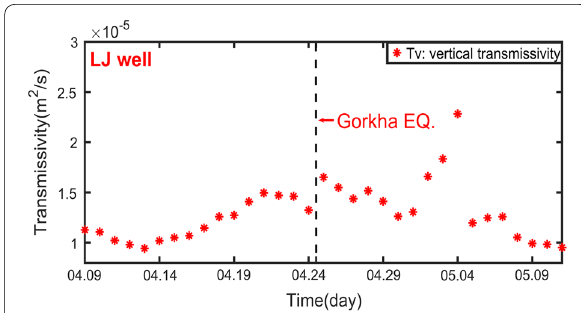
Fig. 10 Time-dependent transmissivity of the LJ well based on M2 tide analysis. Dotted line shows the origin time of 2015 Gorkha earthquake. Tv is calculated from the vertical pore-pressure diffusion